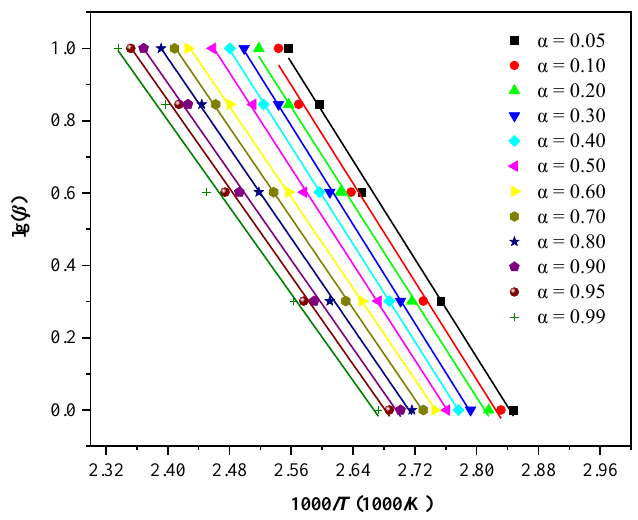
Figure 9. In the DSC experiment, when β is equal to 1, 2, 4, 7, and 10 °C/min, the α - E a and α - R 2 polyline of LP30 + PFPN under the KAS model.